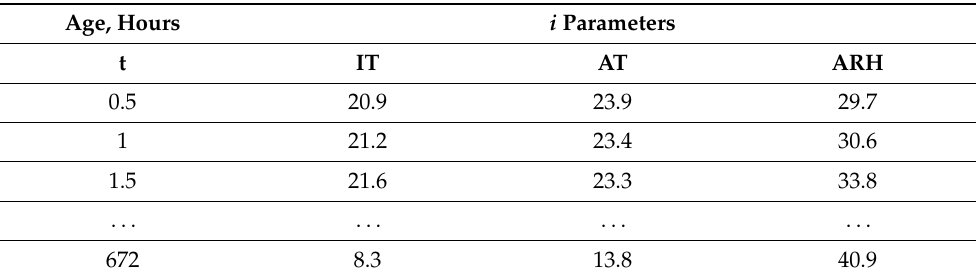
Table 3. Field-testing log.